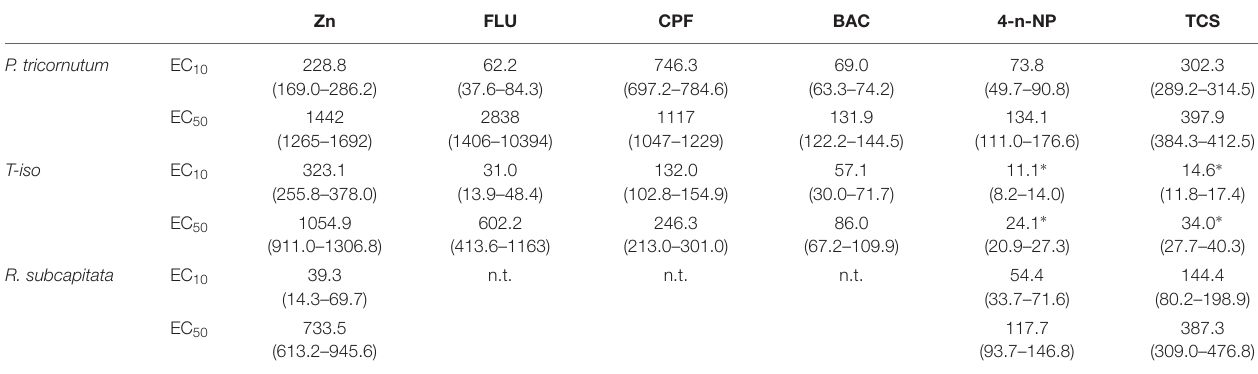
TABLE 2 | Effective concentrations ( µ g L − 1 ) obtained in the growth inhibition test for zinc (Zn), fluoranthene (FLU), chlorpyrifos (CPF), Benzalkonium chloride (BAC), 4-n-nonylphenol (4-n-NP) and triclosan